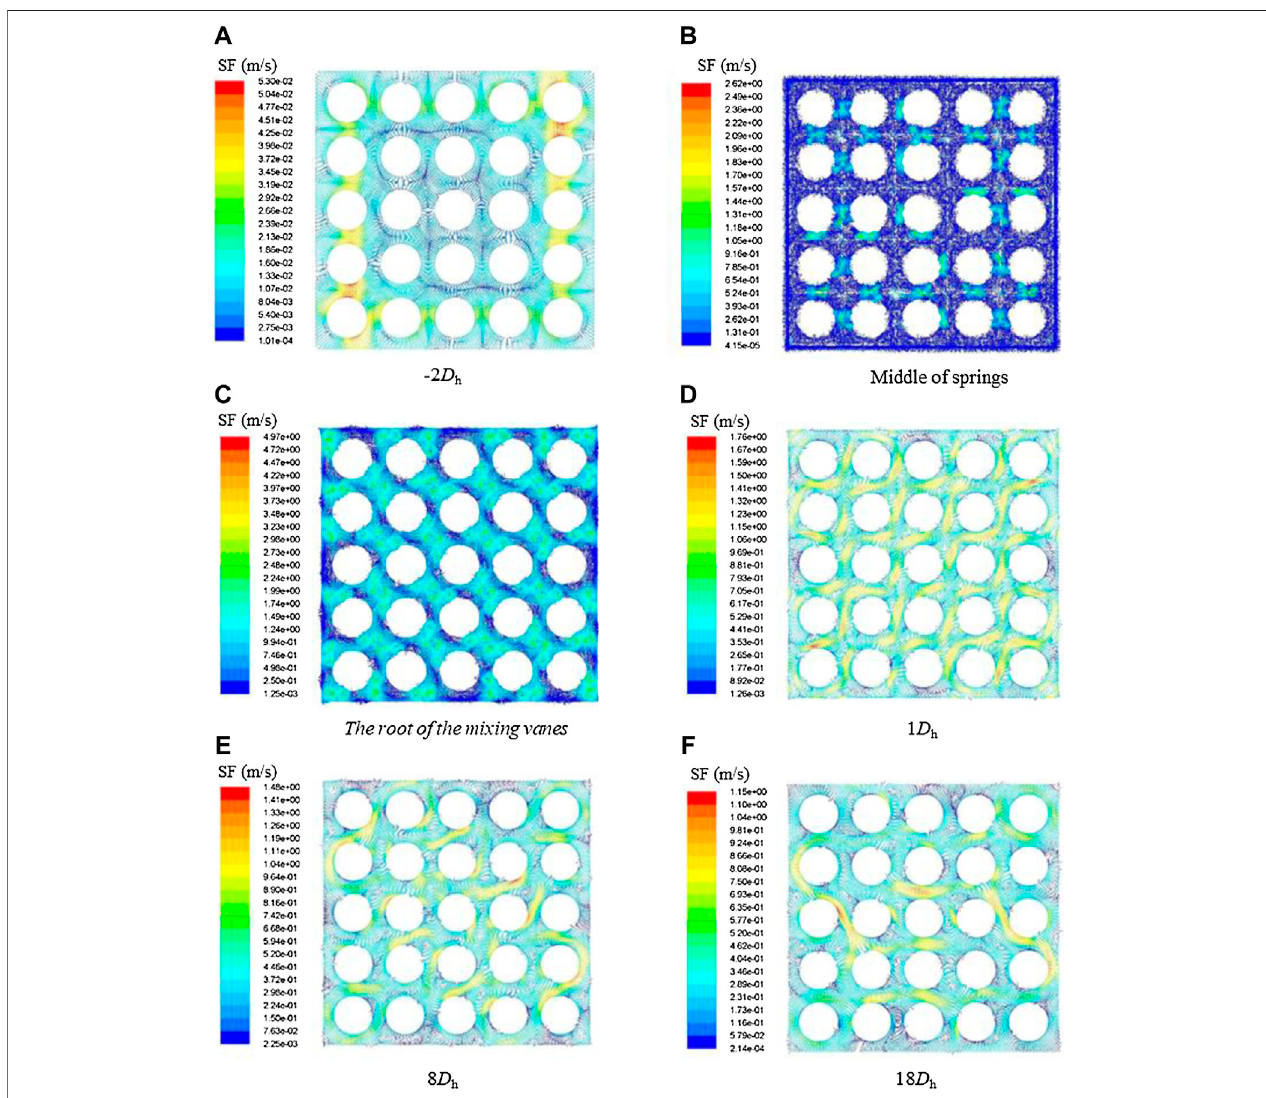
FIGURE 3 | Cross-sectional pro fi le of secondary fl ow along axial